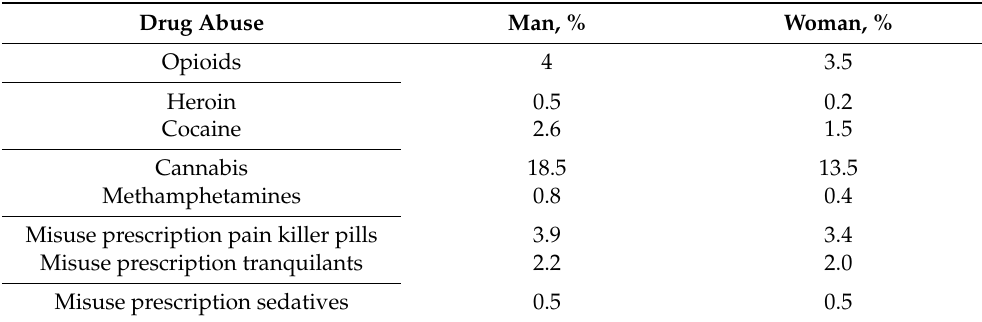
Table 2. World data on drug abuse by sex or gender according to National Center for Drug Abuse Statistics in population aged 15–64 [108].